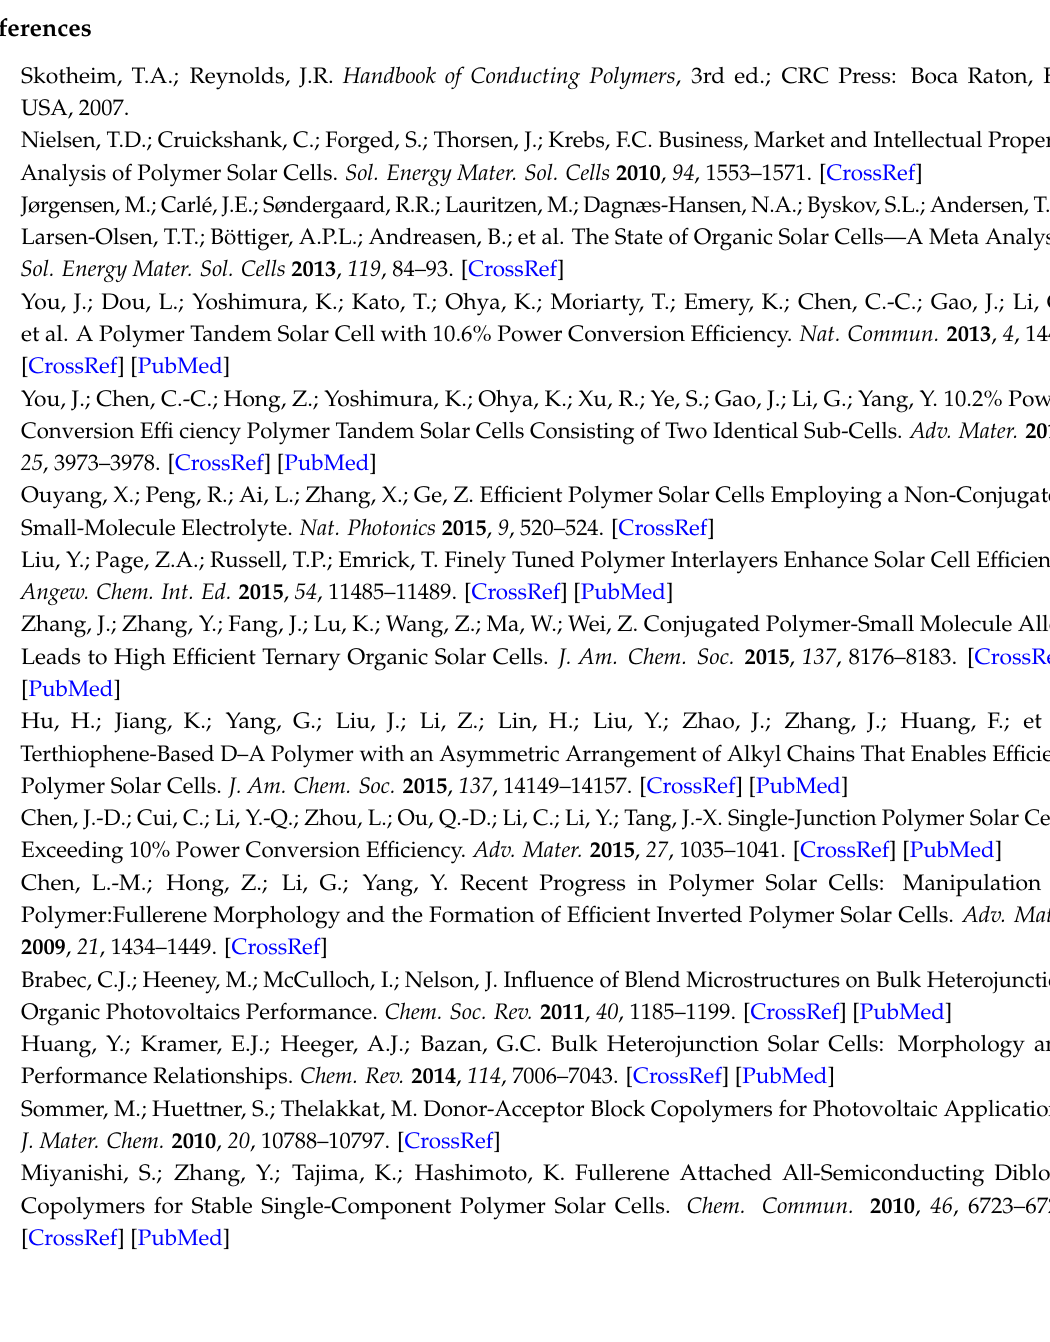
Figure S1: Fluorescence spectra of P3HT NFs ( A ) and BCP3 NFs ( B ) in the presence of QDs with PDTC ligands of various weight ratios. Inserts: corresponding Stern-Volmer